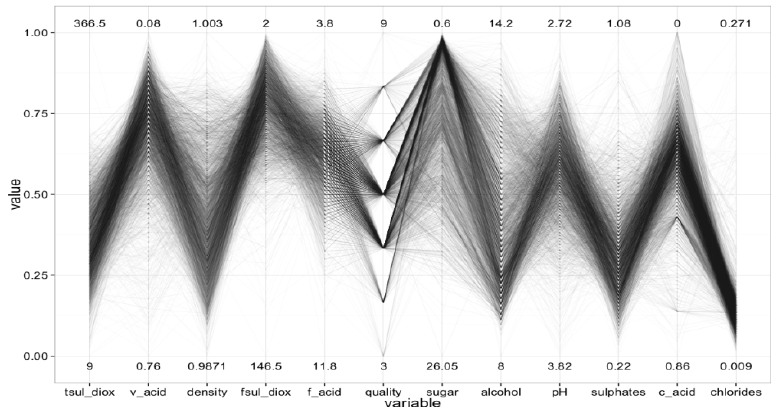
Figure 6. A Wine data set with 4866 samples. By applying reordering technique 31 outliers (unimportant pins) were removed from this dataset. The figure is taken from